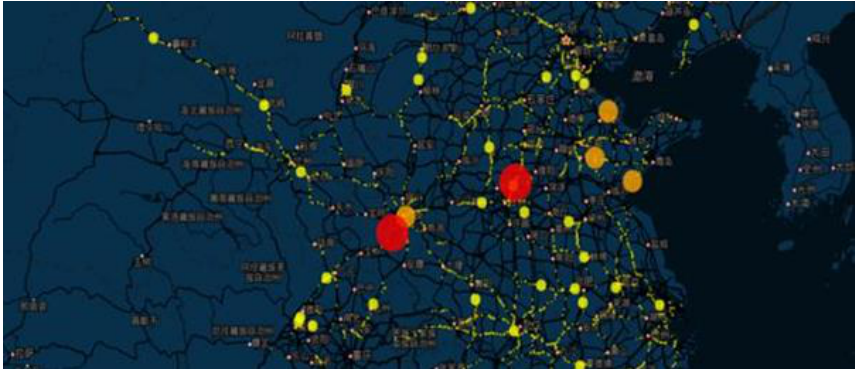
Figure 3 Spatial distribution visualization using map and scatter plot (simulating